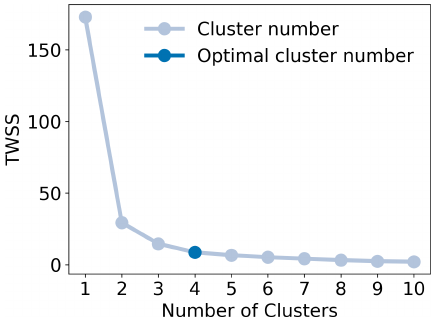
Figure 7. Elbow plot for k -means clustering with automated com- pound selection for the PC1 and PC4 pair. The dark blue marker indicates the optimum number of clusters.